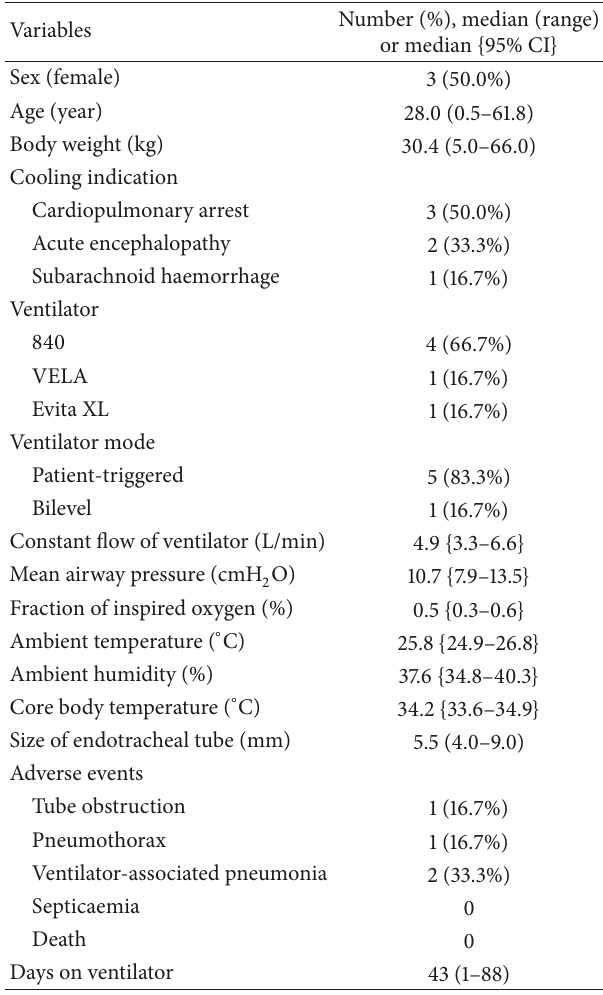
Table 1: Clinical background variables of the study